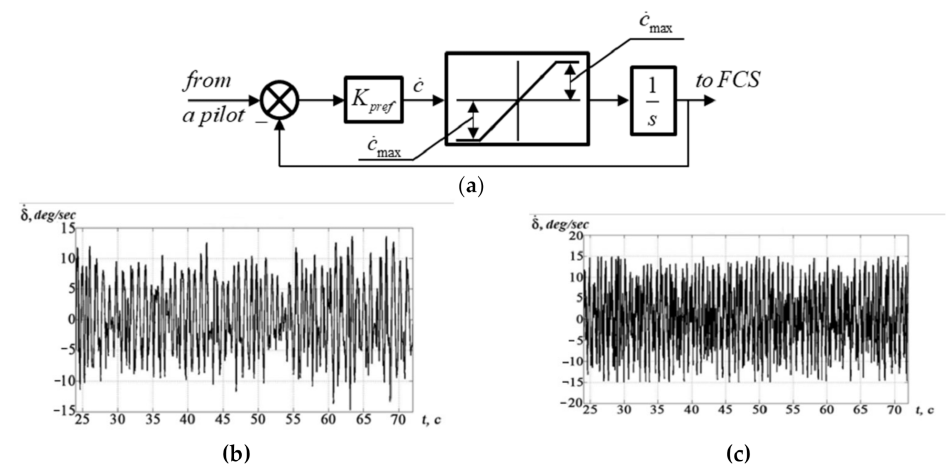
Figure 18. Effect of a non-linear prefilter. ( a ) function demonstration of nonlinear prefilter, ( b ) DSC, ( c )